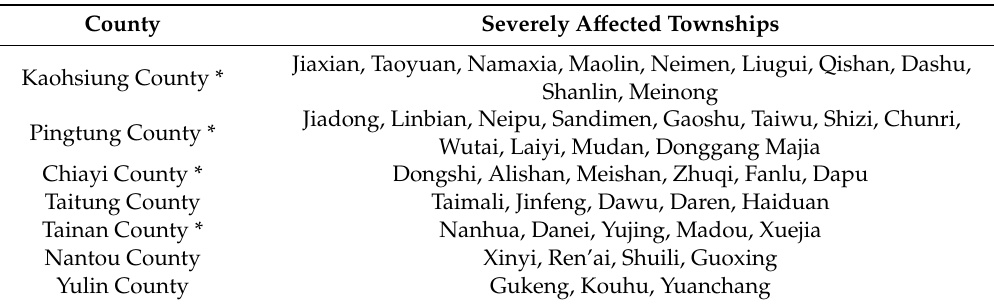
Table A1. A ff ected Townships of Typhoon